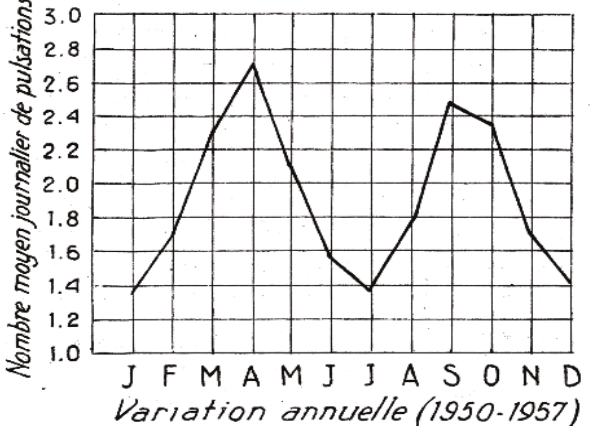
Figure 6. Répartition diurne des pt à Tamanrasset de 1950 à 1957 (d’après Billaud et Bureau).